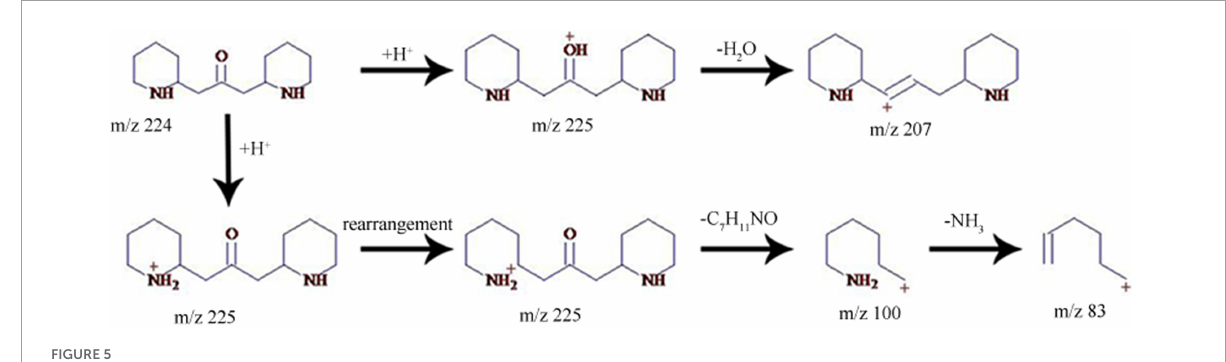
FIGURE5 The putative fragmentation pathway of